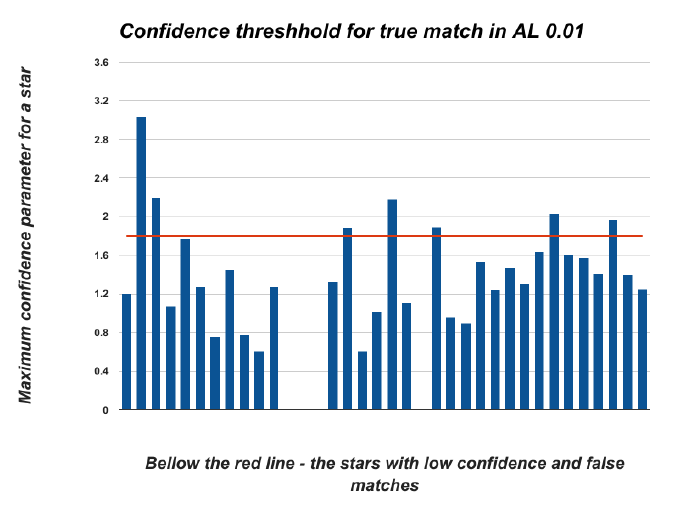
Figure 11. Confident thresh-hold for true match in AL